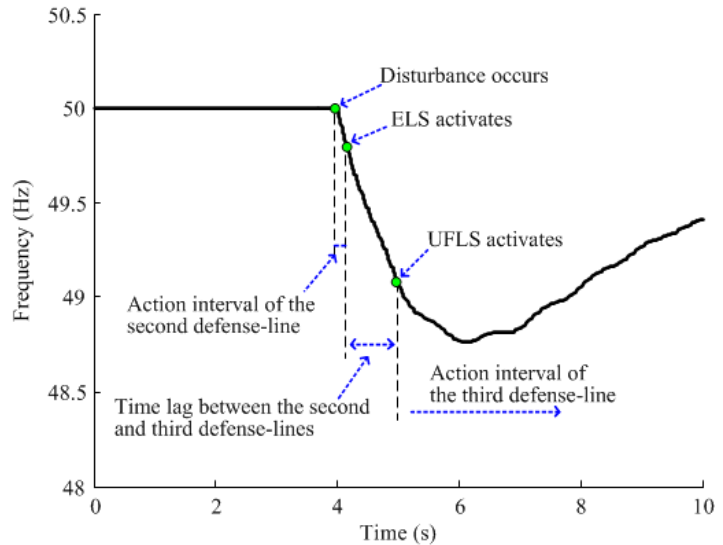
Figure 5. Frequency stability control process under large power deficits.